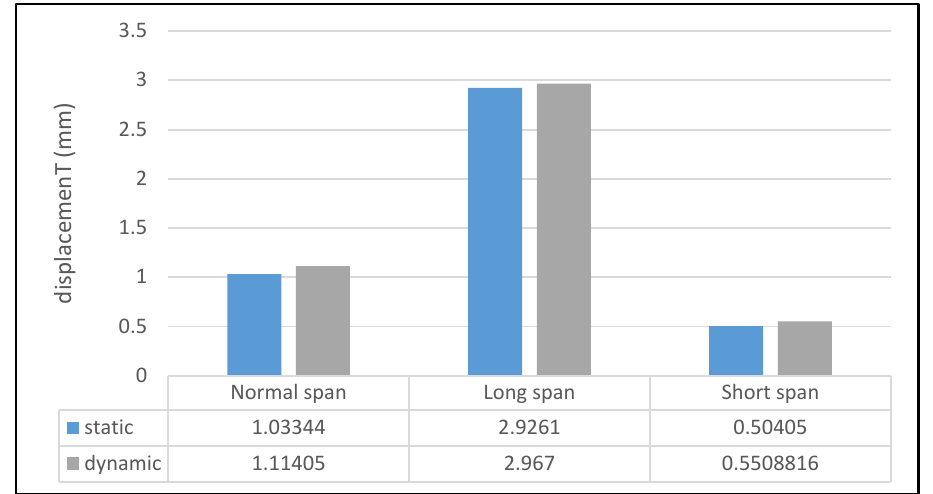
Fig. 10. Mid-span displacement comparison under different span length